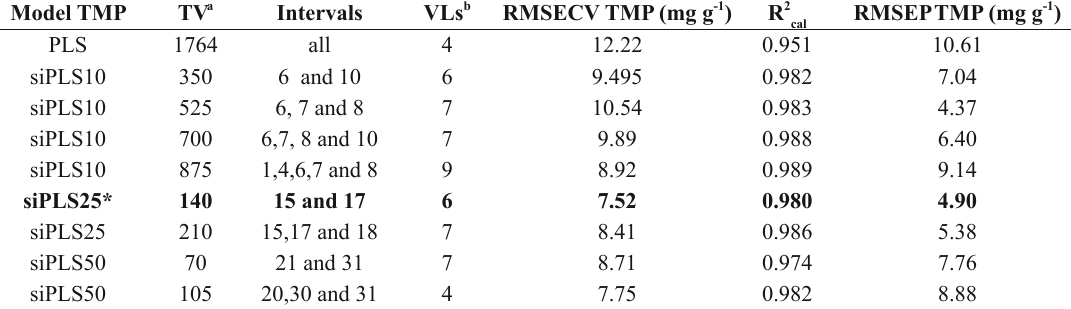
Statistical results to si PLS calibration models and full-spectrum PLS model for the